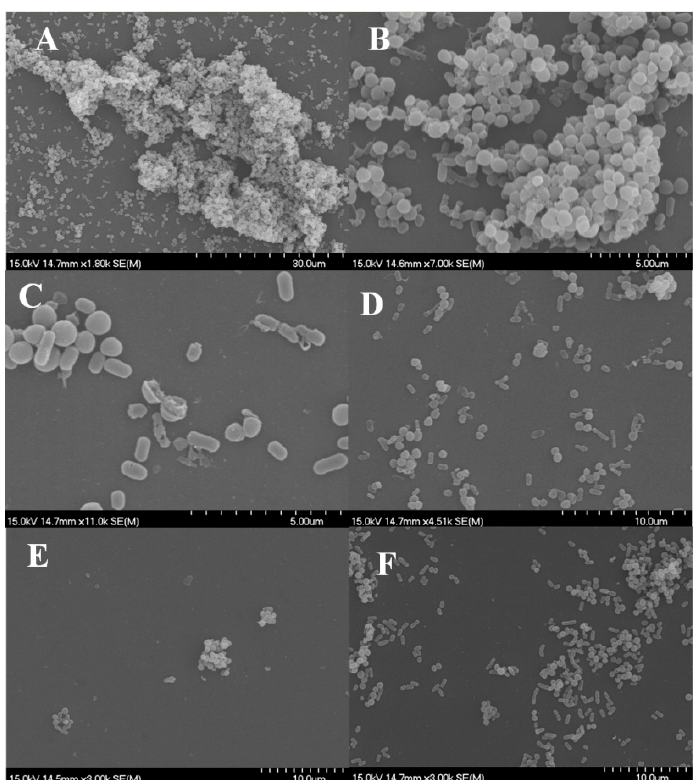
Figure 5. Listeria monocytogenes and Staphylococcus aureus biofilms observed using scanning electron microscope. A, B: control, C: marjoram essential oil (EO) (1.6 mg/mL), D: terpinen-4-ol (8 mg/mL), E: microscope. ( A , B ) control, ( C ) marjoram essential oil (EO) (1.6 mg / mL), ( D ) terpinen-4-ol (8 mg / mL), thyme EO (0.4 mg/mL), and F: thymol (0.8 mg/mL). ( E ) thyme EO (0.4 mg / mL), and ( F ) thymol (0.8 mg / mL). Microorganisms 2019 , 7 , x FOR PEER REVIEW